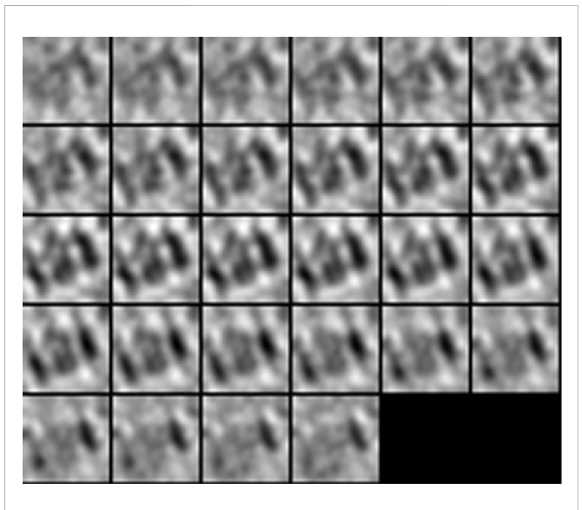
FIGURE 7 2D subtomogram slice visualization of T20 S proteasome (EMPIAR 10143) macromolecule, extracted from Noble single particle